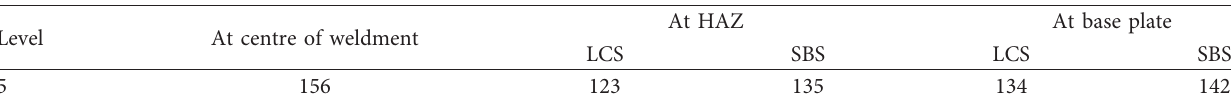
Table 21: Hardness (HV) of dissimilar double V 45 °